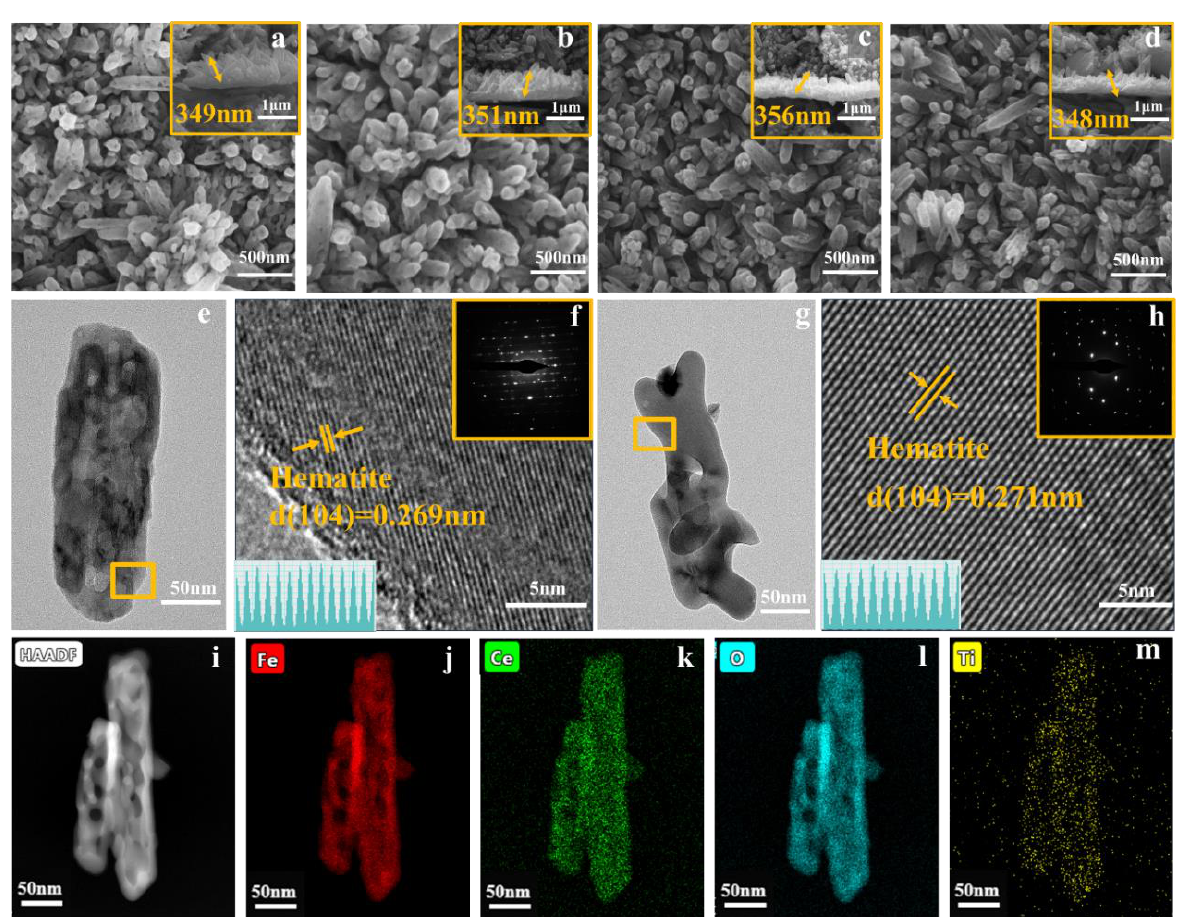
Figure 2 . SEM and Side view of FT ( a ), 1CFT ( b ), 5CFT ( c ) and 10CFT ( d ); TEM of FT ( e ), 5CFT ( g ); HRTEM of FT ( f ), 5CFT ( h ) (Inset is SAED); HAADF ( i ) and EDS Mapping maps ( j – m ) of